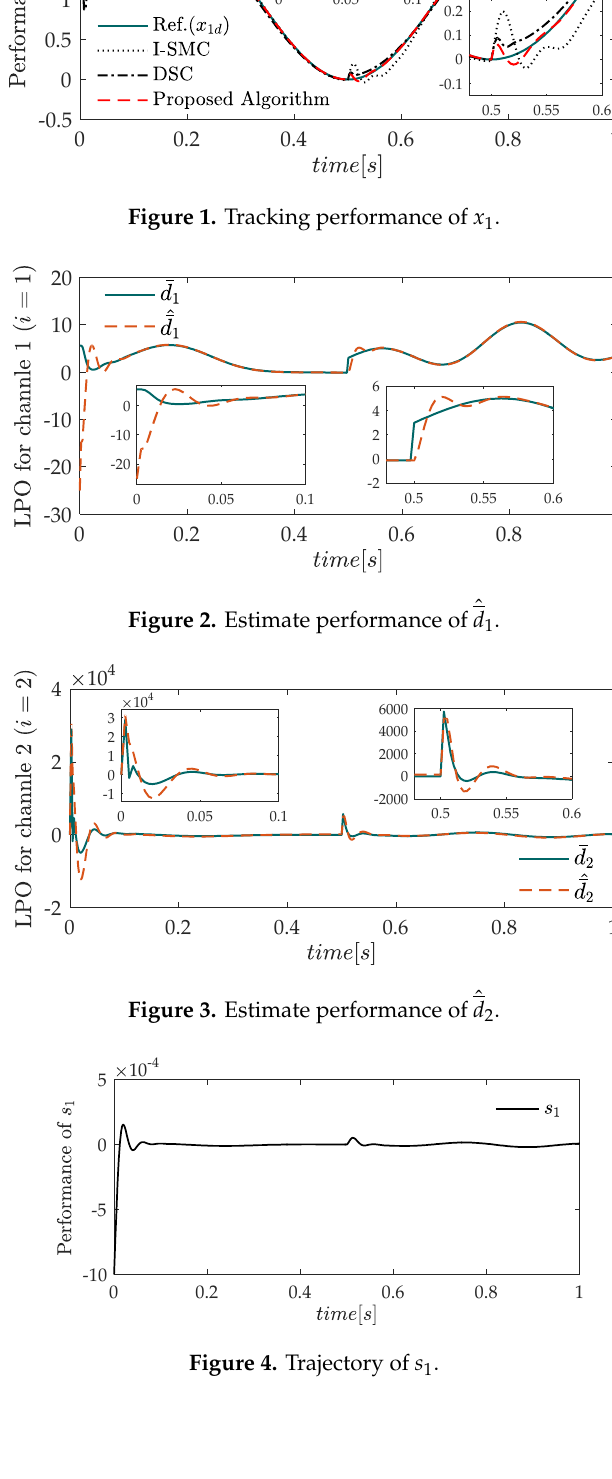
Figure 5. Trajectory of s 2 . Figure 6. Trajectory of 1 G . Figure 7. Trajectory of 2 G . Figure 8. Controller performance.